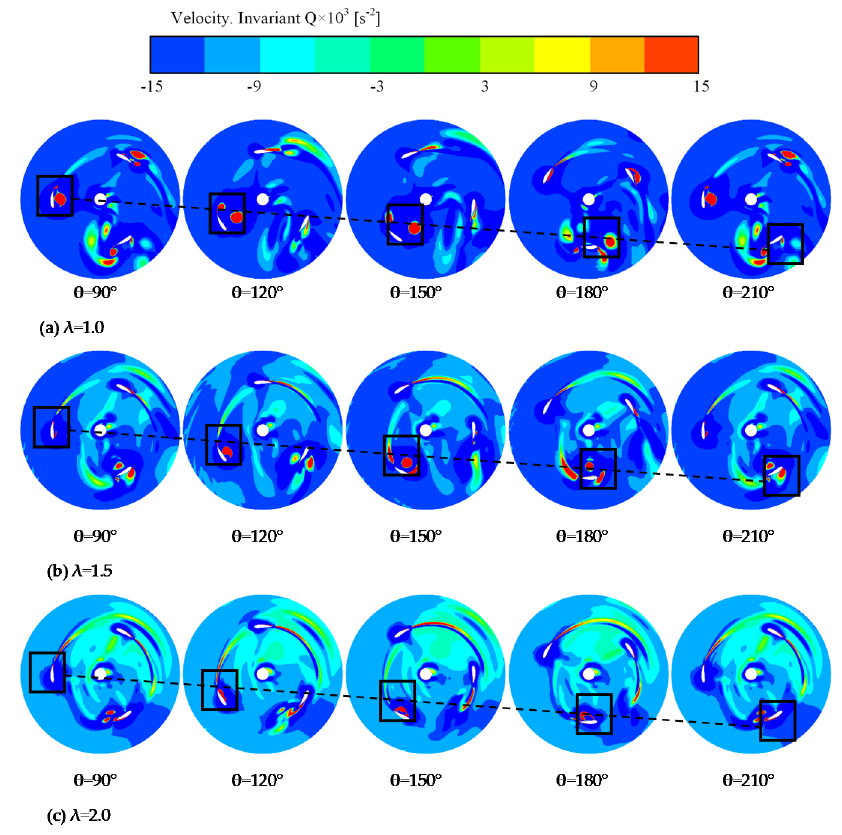
Figure 12. Plane distribution of 75% H b vorticity of the turbine.